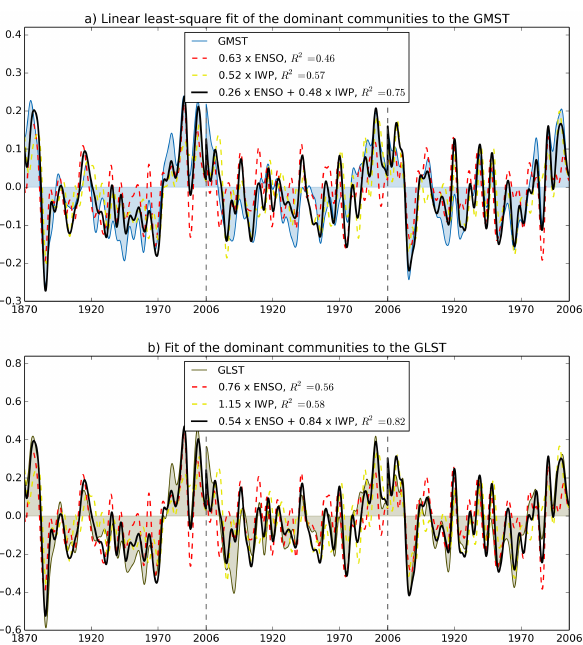
Fig. 10. Regression of the mean time series of the ENSO and IWP Fig. 10: Regression of the mean time series of the ENSO and IWP communities of the ESMP-LP8y communities of the ESMP-LP8y network to the (a) GMST and (b) network to the (a) GMST and (b) GLST. GLST.